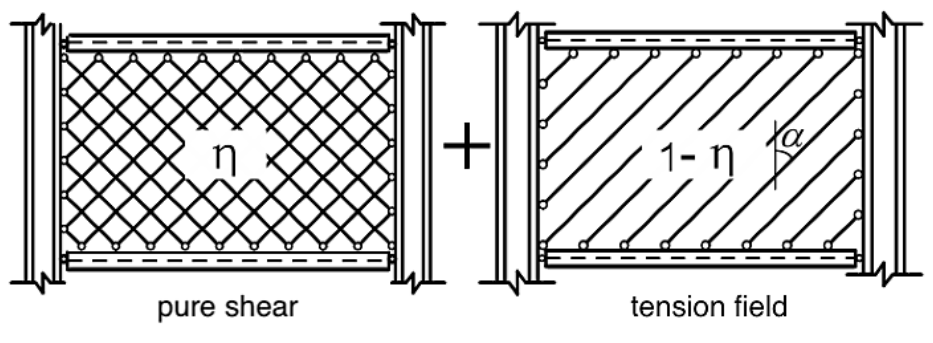
Figure 3. Unified Strip Model.